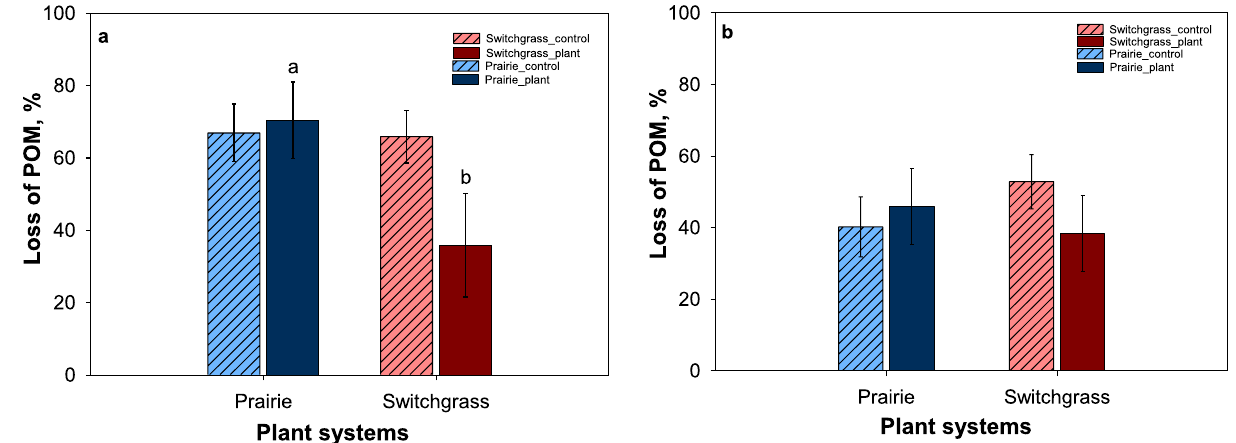
Figure 8. Amount of particulate organic matter (POM) decomposed in depression ( a ) and slope ( b ) topography in control cores (dash) and plant grown cores (solid) of prairie and switchgrass cropping systems. Data shown are means ± SE (n = 3). Letters indicate significant differences between cropping systems positions in control and plant grown cores in each topographical position (p <